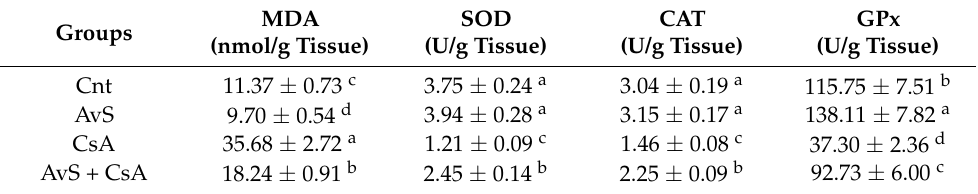
Table 6. Effects of avocado seed powder on oxidant/antioxidant status of kidney. Groups